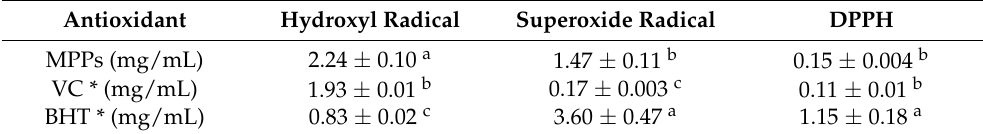
Table 3. The antioxidant index IC 50 values of MPPs, VC and